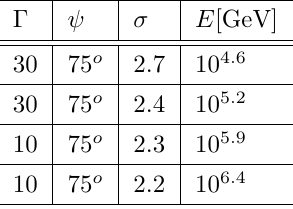
Table 3: In the tables above we see indicative simu- lation numbers for two sets of four-shocks, their max- imal attained energies E at each shock downstream, and their spectral indices σ . Shock inclination angles are denoted as ψ , and Γ is the shock Lorentz